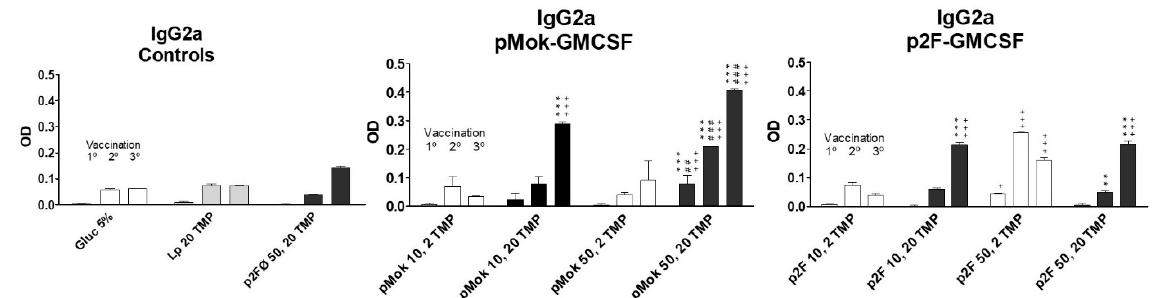
Figure 6. IgG2a response obtained after each vaccination dose in the different formulations of multicompartmental lipopolyplex loaded with a water-soluble protein extract (TMP). Lipolyplexes contained 10 or 50 µg of plasmid (pMok or p2F) bearing murine GM-CSF gene and 2 or 20 µg of TMP. * symbol is employed to define the statistically significant difference due to the amount, 2 or 20 µg, of TMP (** p < 0.01; *** p < 0.001) in each vaccination. # symbol indicates the statistical significance due to the amount, 10 or 50 µg, of GM-CSF (## p < 0.01; ### p < 0.001) in each vaccination. + symbol is employed to define the statistically significant difference with respect to Glucose 5% control group. ( + p < 0.05; + + + p < 0.001) in each vaccination.